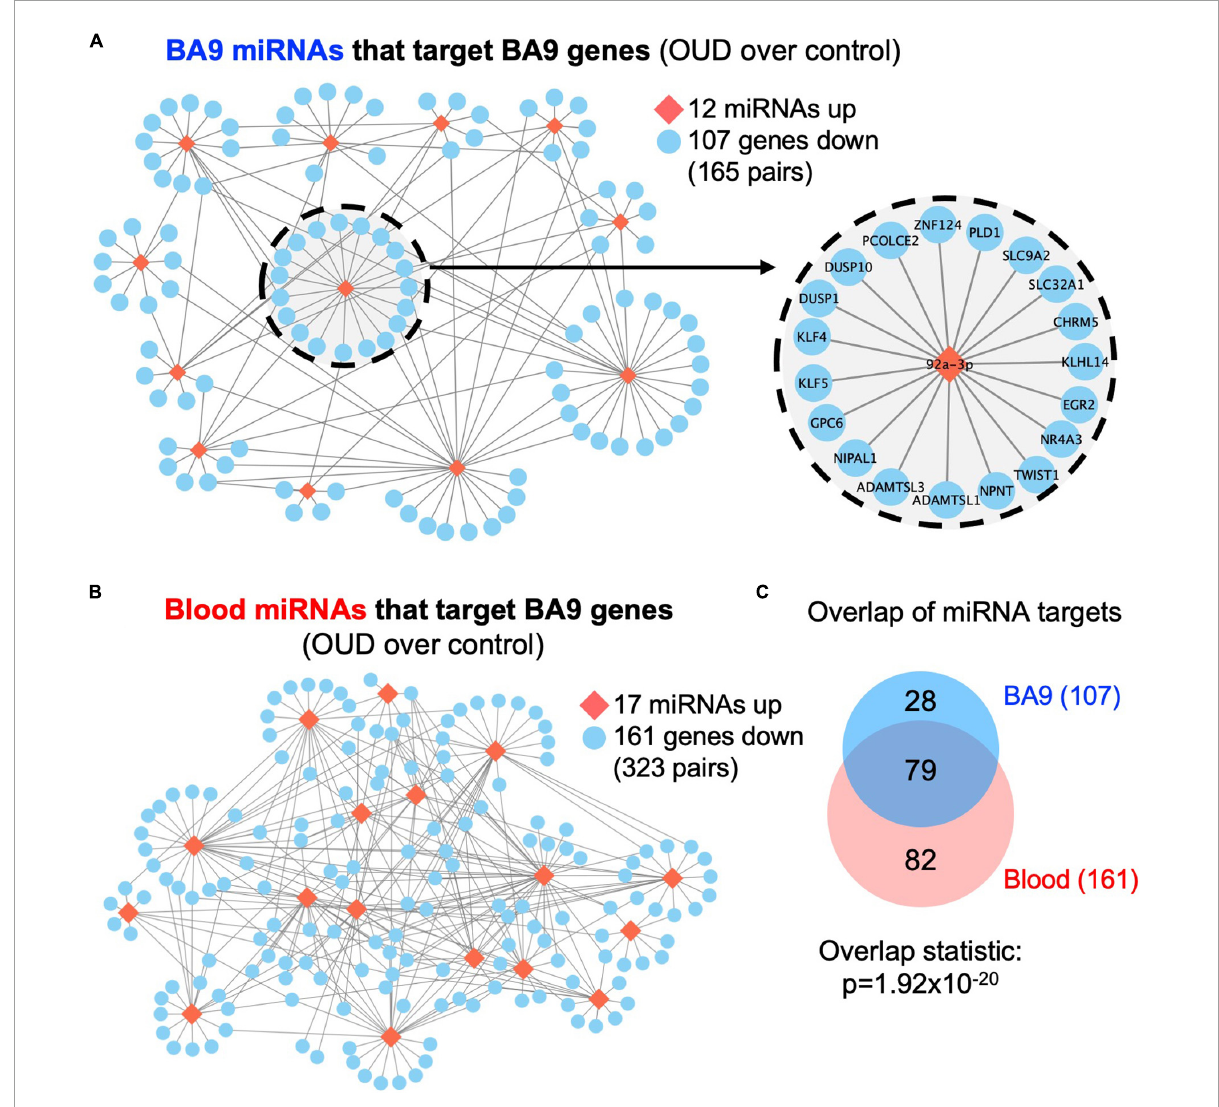
FIGURE3 Dysregulated miRNA–mRNA networks in brains from opioid use disorder (OUD) donors. Using the significant dysregulated protein coding genes measured in BA9, we determined enriched miRNA targets based on the OUD-associated miRNA candidates measured in panel (A) BA9 and (B) blood via the mirDB compendium. (C) Overlap of down regulated genes targeted by miRNAs in BA9 and blood. Network of genes targeted by miR-92a-3p is enlarged in panel (A)